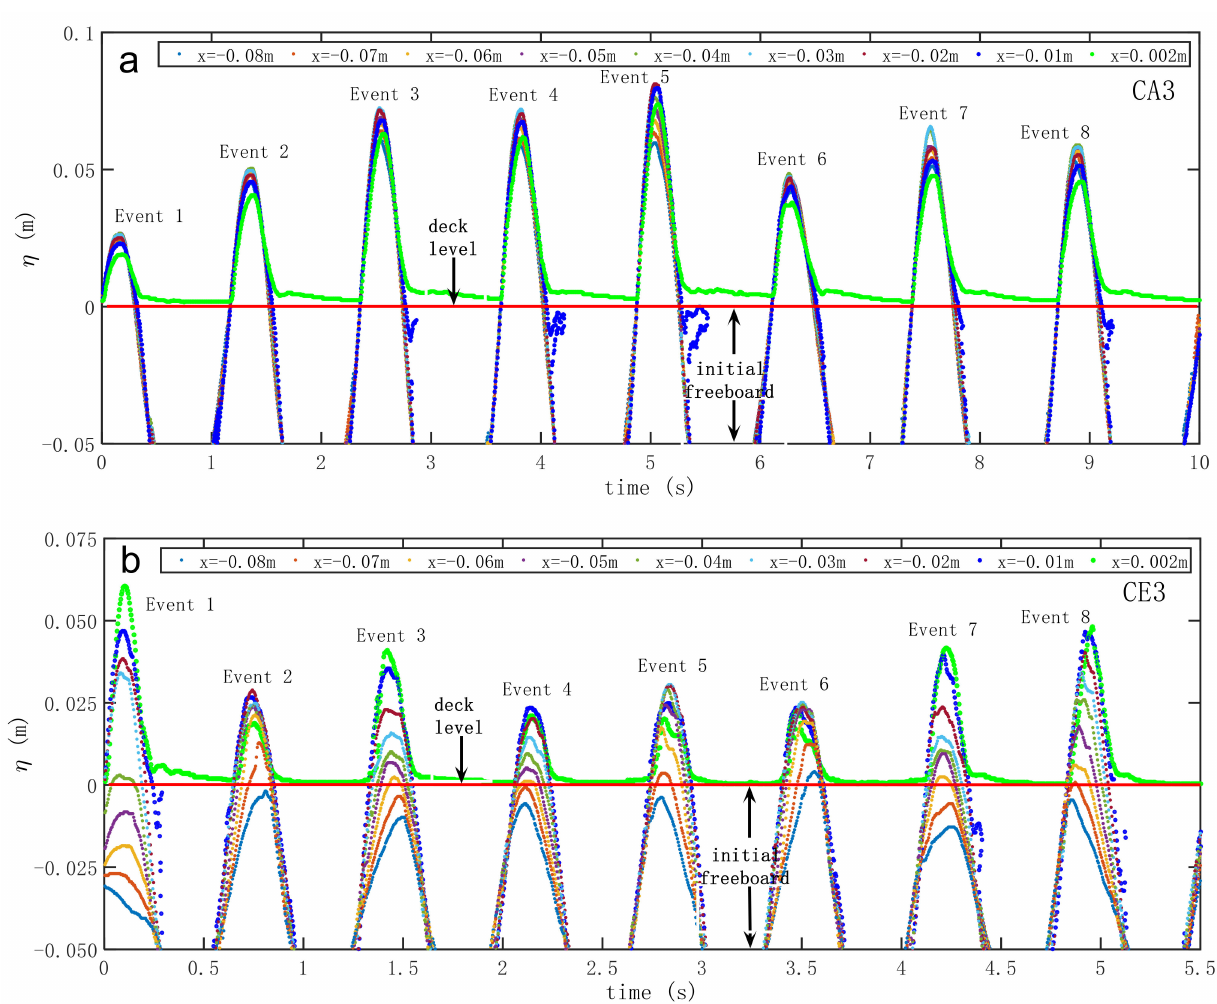
Figure 7. Time series of water surface elevations ( η ) obtained from virtual probe d2 (over the deck, x = 0.002 m) and from probes w10 to w80 (outside the deck, from x = − 0.01 m to x = − 0.08 m), for eight consecutive green water events. ( a ) Data for CA3. ( b ) Data for